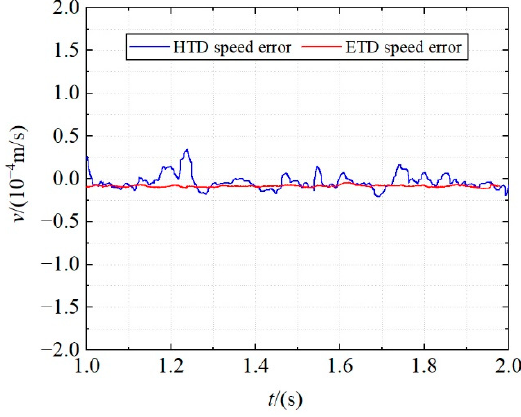
Figure 21. The steady-state errors of HTD and ETD.